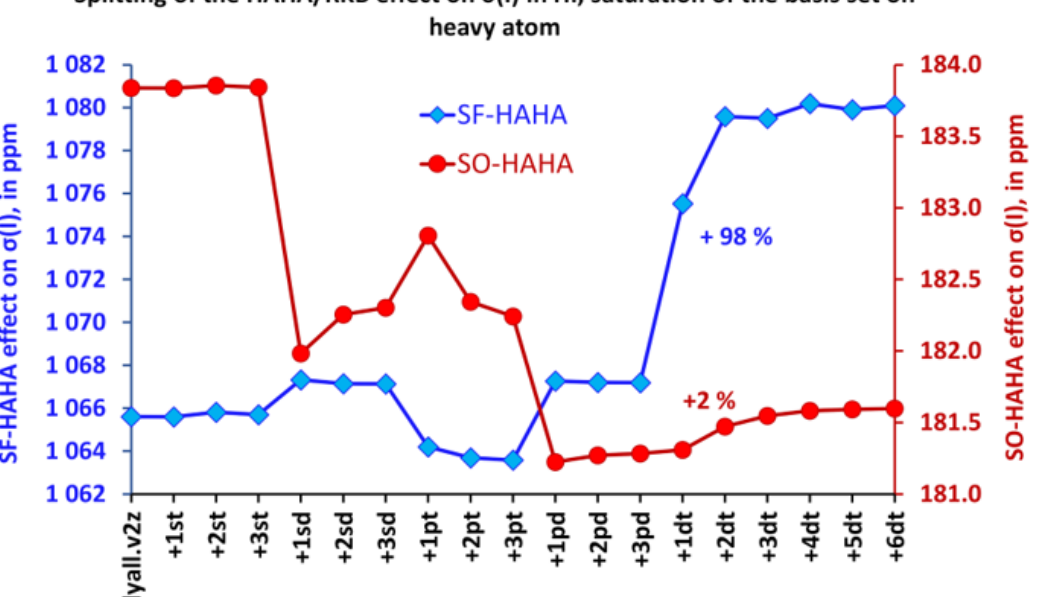
Figure 5. Splitting of the HAHA effect into SO and SF contributions in the HI molecule while saturating the basis set on the iodine atom.